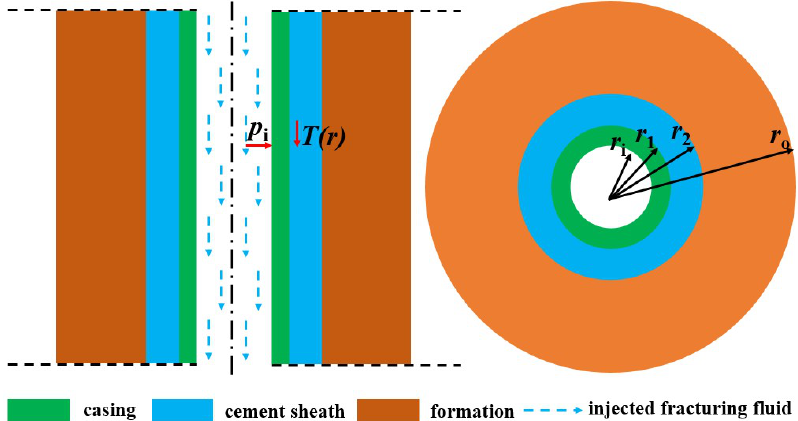
Figure 1. The schematic diagram of casing-cement sheath-formation combined system during fracturing fluid injection.